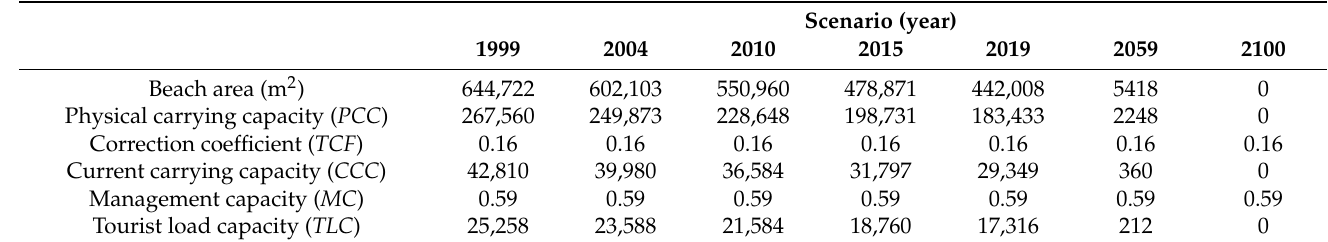
Table 13. The tourist load capacity for Mazatlan.